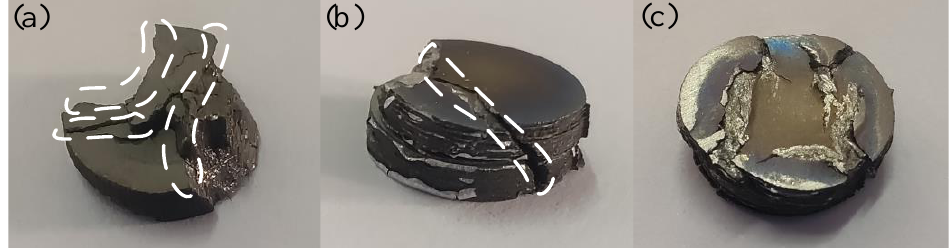
Figure 4. The specimen after fracture and the fracture morphology observed under electron microscope: ( a ) Without Al, ( b ) containing about 15% Al, ( c ) containing about 30% Al.